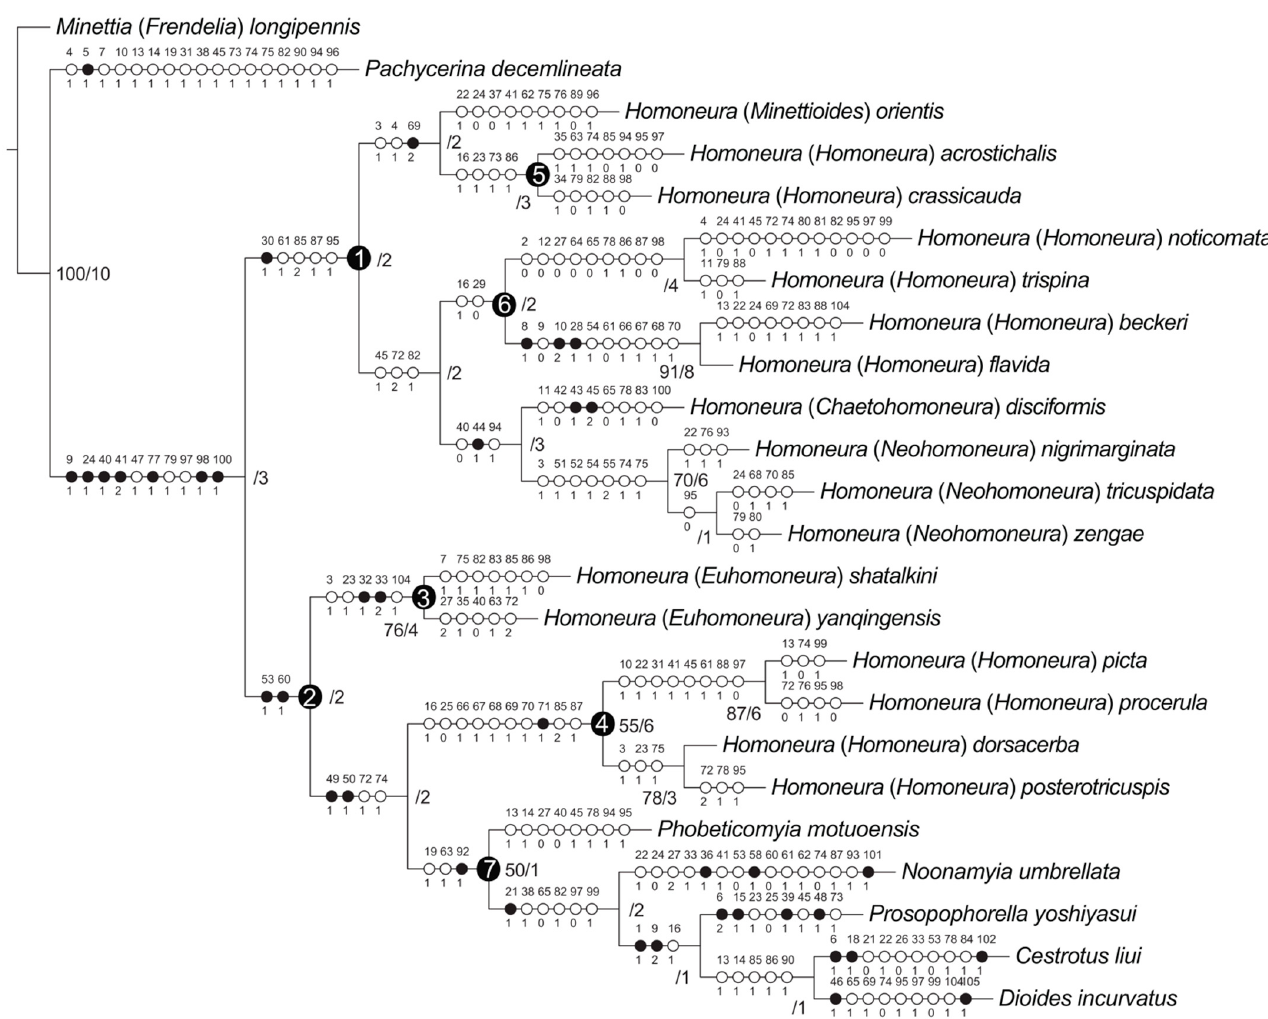
Figure 10. Phylogenetic relationships of Homoneura. Synapomorphies are marked by filled circles and homoplasious characters by open circles. The character numbers and states are placed above and below the circles, respectively. Bremer support: left, bootstrap values > 50%; right, Bremer support